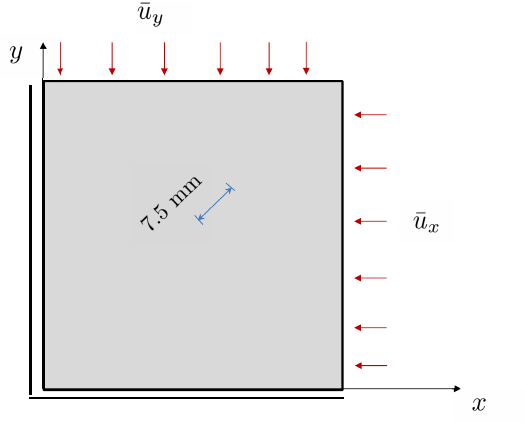
Figure 4. Specimen with inclined flaws: geometry and loading conditions.